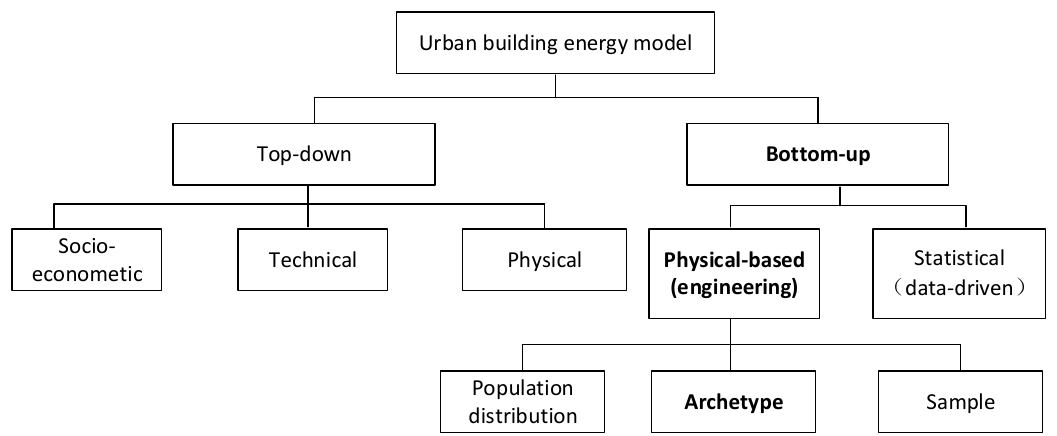
Figure 2. Approaches to modelling urban building energy.